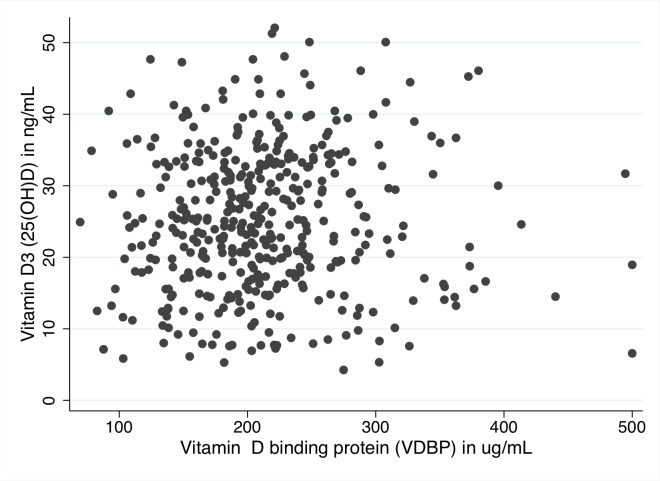
Scatterplot of measured 25(OH)D and Vitamin D binding protein in 426 and 424 COPD patients respectively.